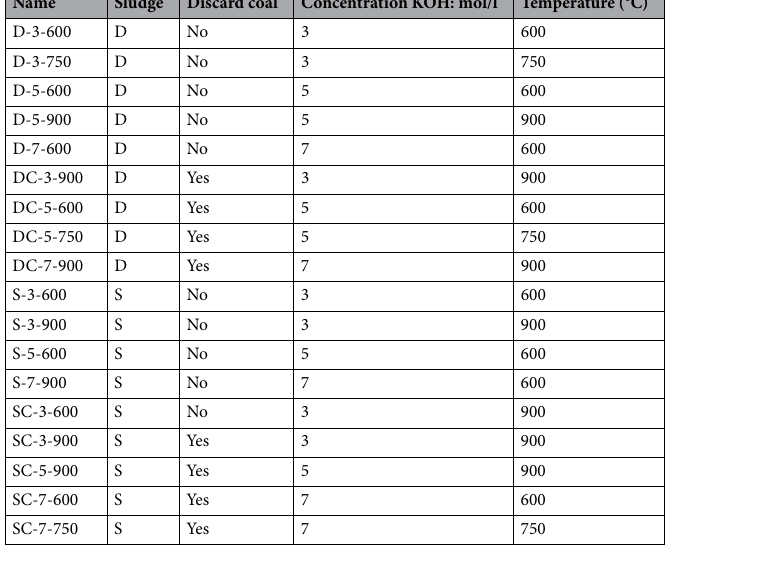
Table 2. Nomenclature and conditions of the activation